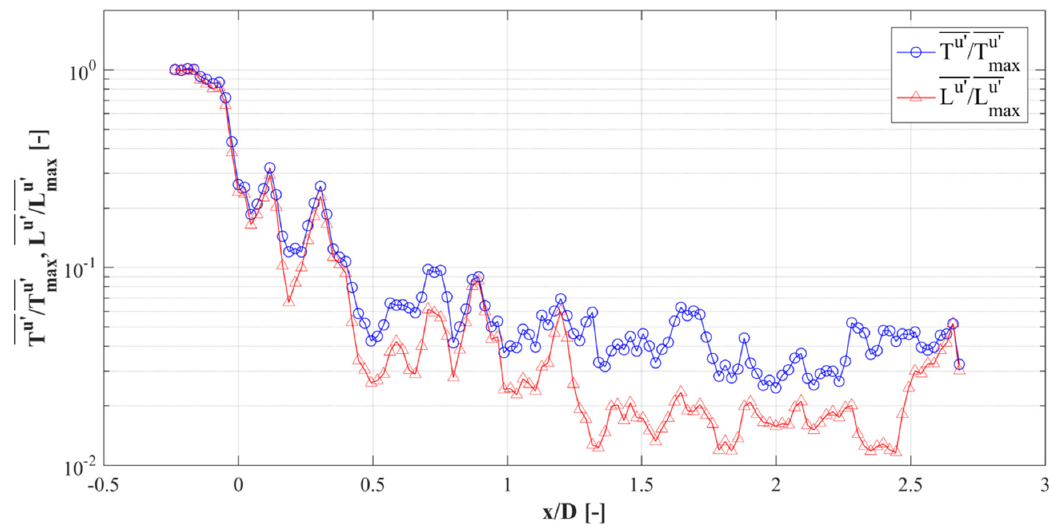
Figure 11. Integral time scale and length scale.